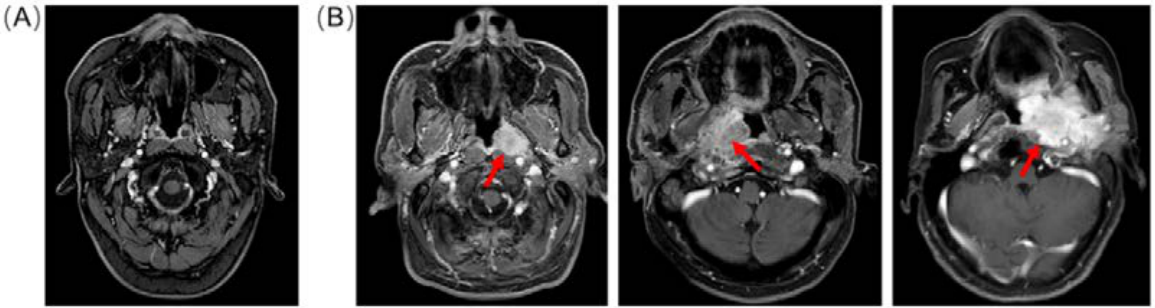
Figure 1. Example of contrast-enhanced T1-weighted MRIs. ( A ) The image from normal control without NPC cancer; ( B ) the images from patients with varying sizes of NPC. The arrows indicate the location of the NPC tumor.